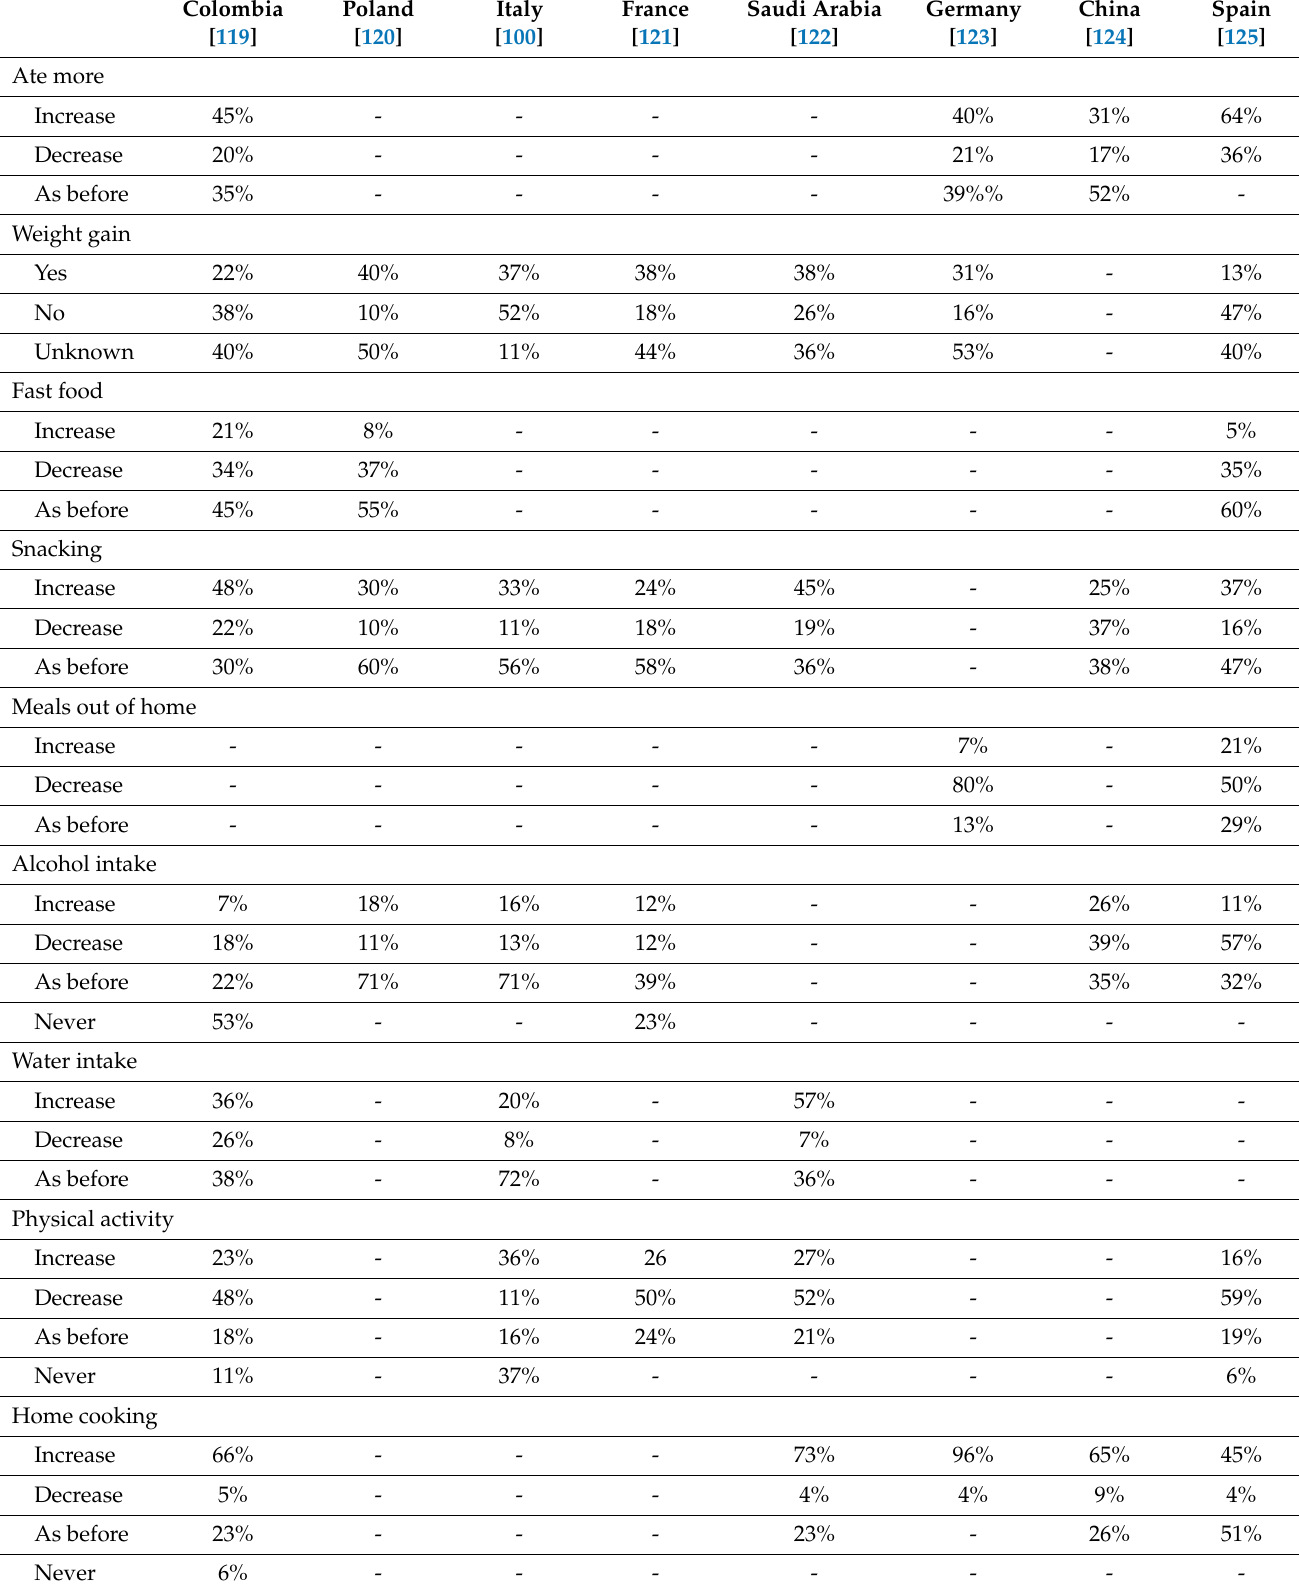
Table 3. Dietary behavior in different countries on